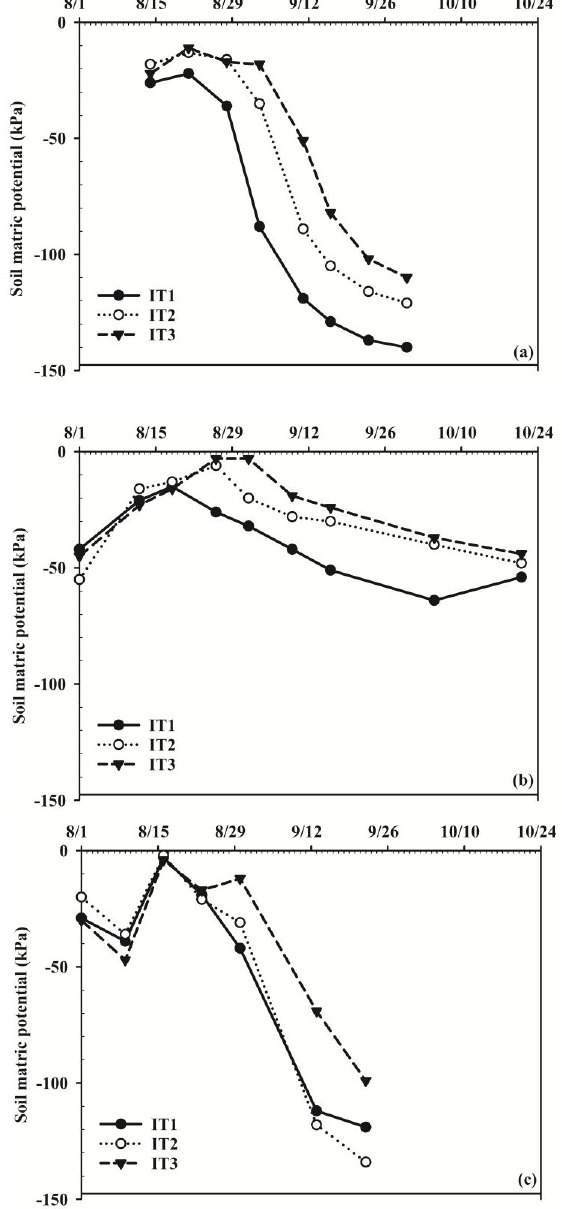
Figure 3. Treatment averages of soil matric potential in ( a ) 2015, ( b ) 2016 and ( c ) 2017.